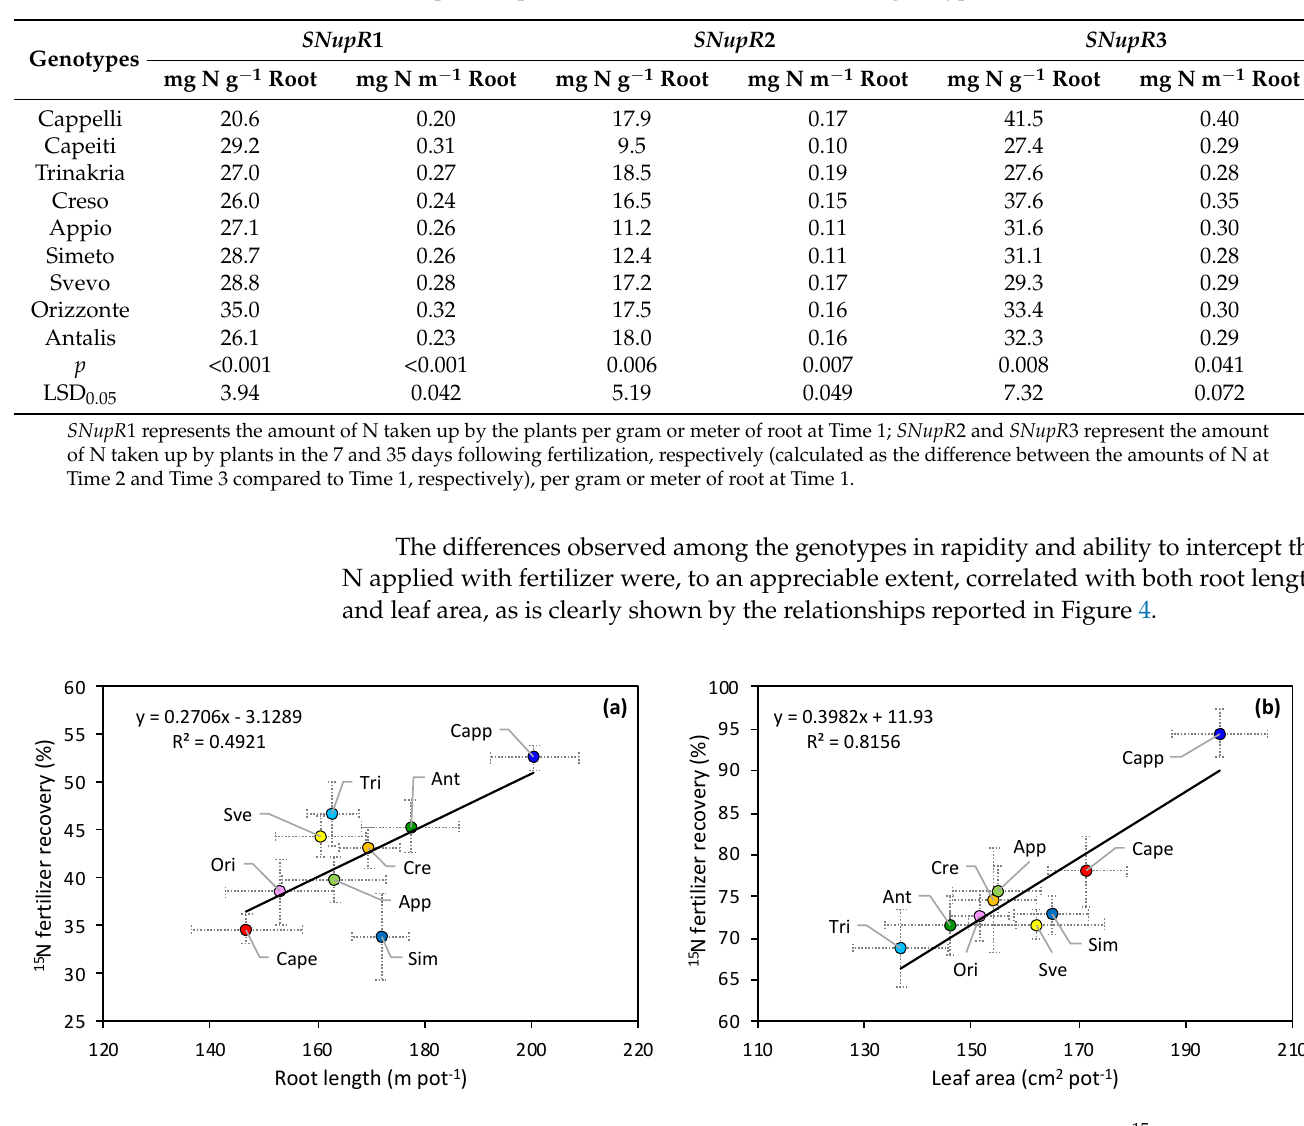
Table 3. Specific uptake ratios of N for the nine studied genotypes.